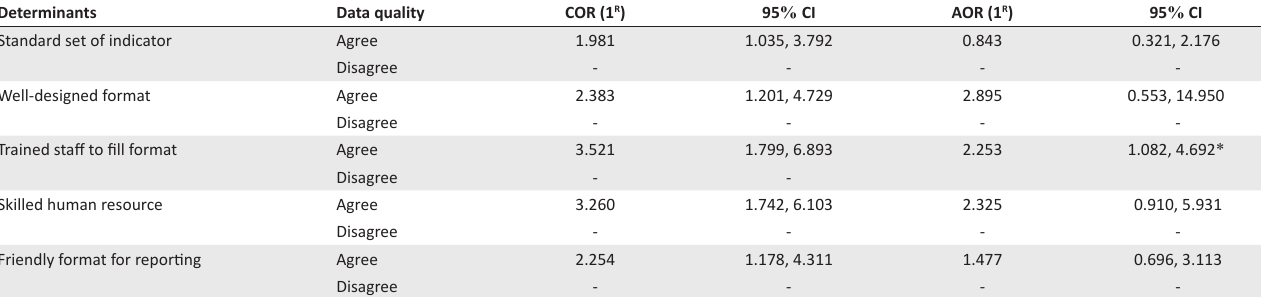
FIGURE 2: Data quality by health facility type in Dire Dawa Administration, April 2013. TABLE 5: Associated technical factors for Data quality in all governmental health facilities in Dire Dawa Administration, April 2005